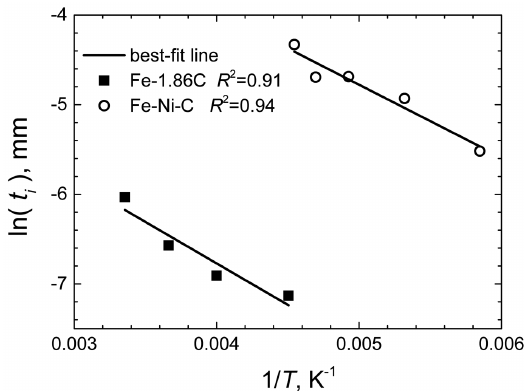
Figure 4. Arrhenius plot of intrinsic thickness of martensite as a function of the quenching temperature for data from Fe-31wt%Ni-0.02wt%C 26-28 and Fe-1.86wt%C 29